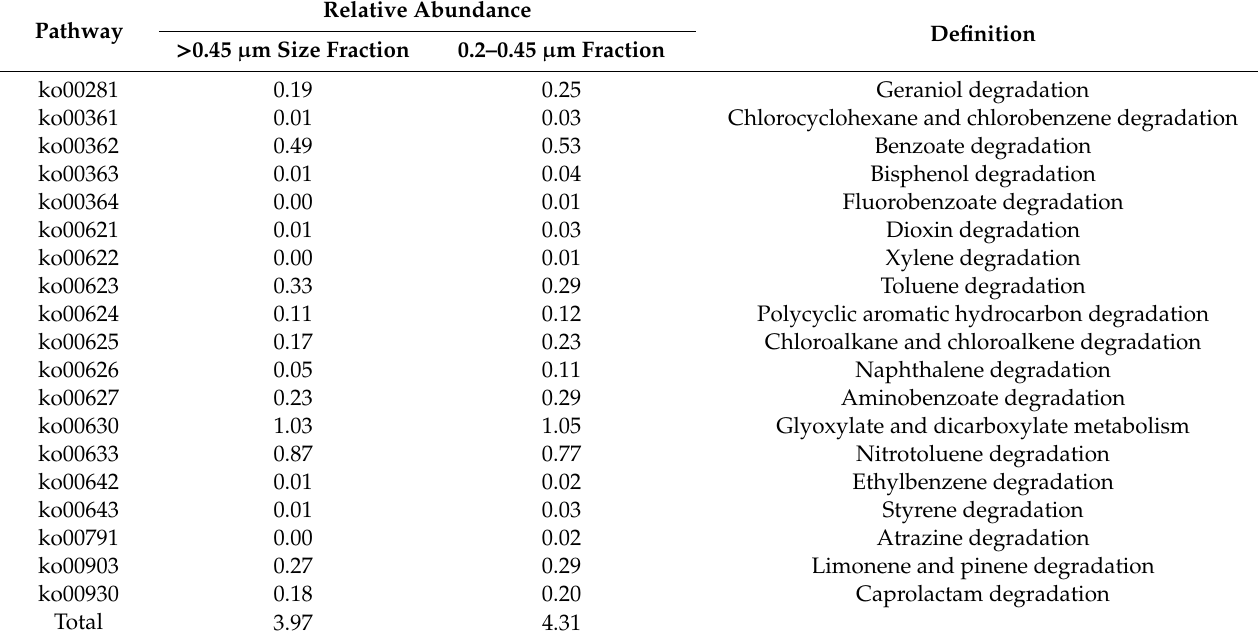
Table 6. KEGG metabolic pathways involved in the degradation of aromatic compounds in archaeal